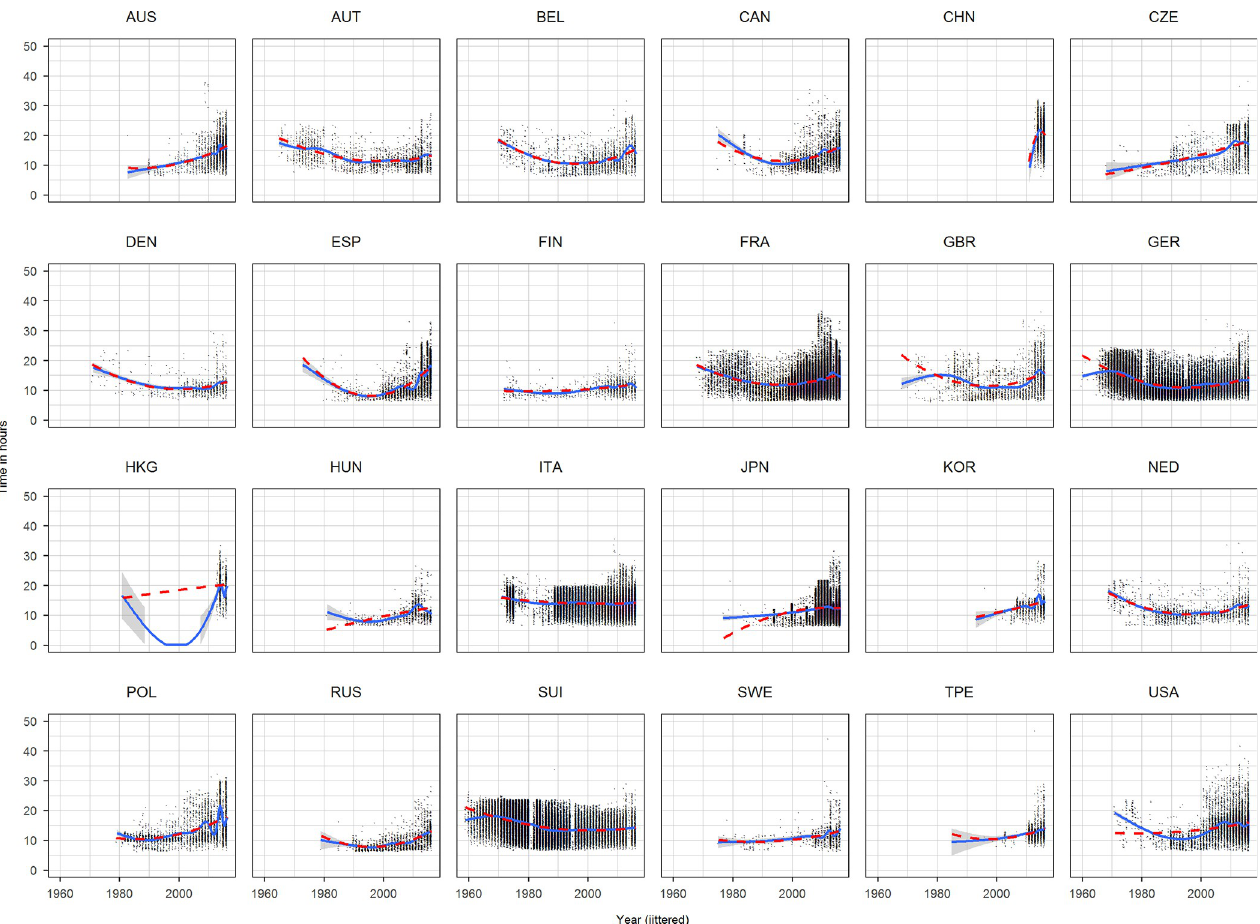
Fig 2. Scatterplots time against race year for each nationality based on the complete dataset. Race year has been jittered.